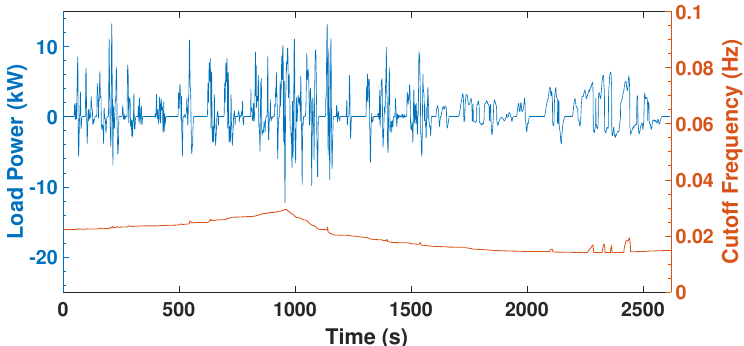
Figure 10. Cut-off frequency derived for the CDP.